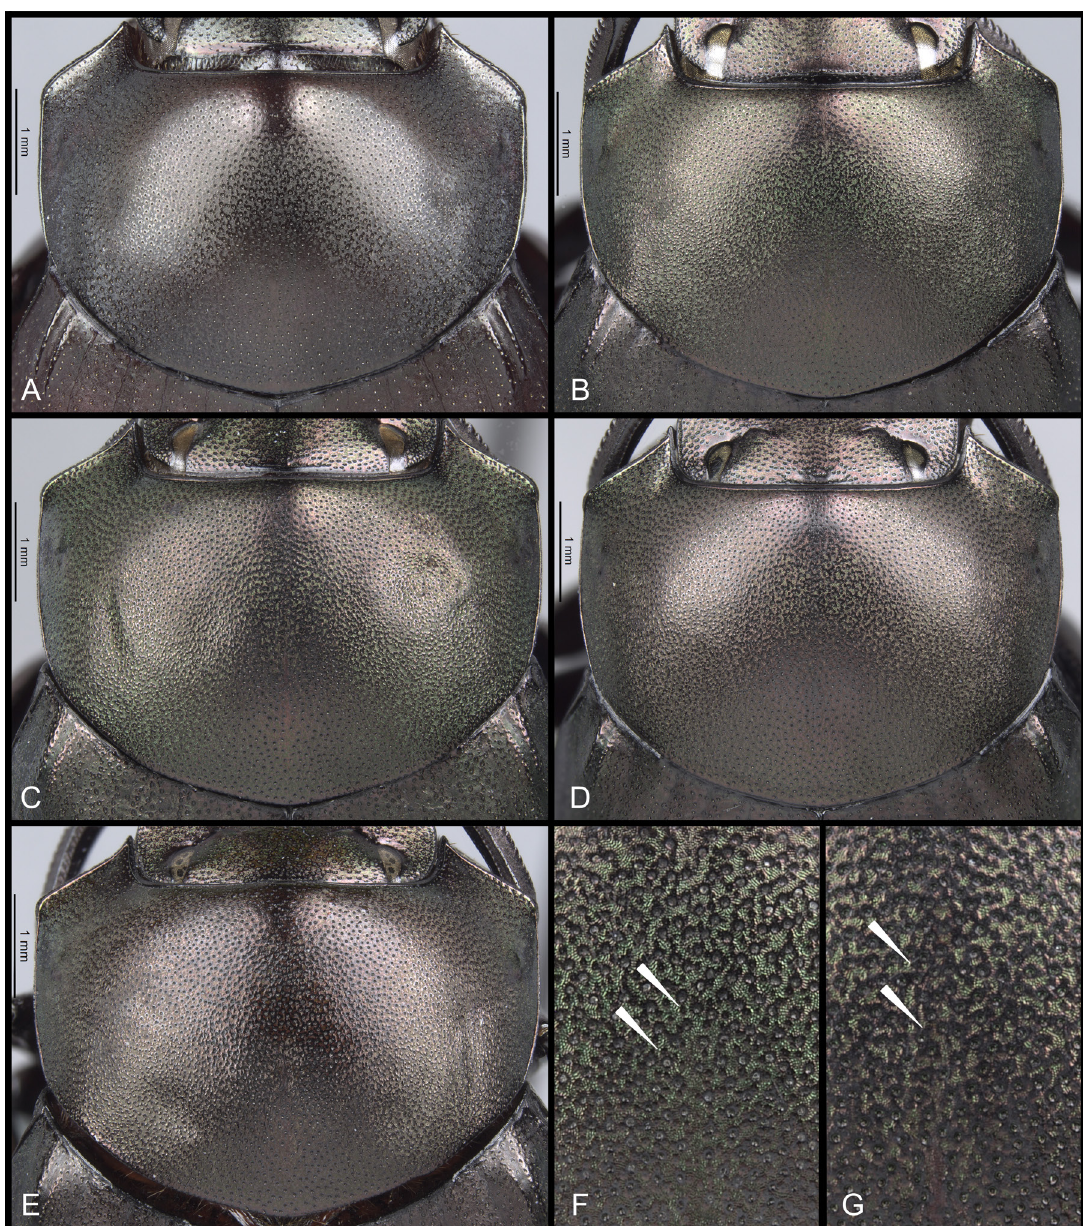
Fig. 3. Pronotum of members of the gilli species group. A . Holotype of Deltochilum gilli González- Alvarado & Vaz-de-Mello, 2021, CNCI 379888. B . Holotype of D. jocelynae sp. nov., CNCI 379889. C . Holotype of D . nonstriatum sp. nov., CMNEN WSD00041746. D . Holotype of D . quasistriatum sp. nov., CMNEN WSD00041744 E . Holotype of D . tenuistriatum sp. nov., CMNEN WSD00041745. F . Miscrosculpture of pronotal disc, Holotype of D. jocelynae sp. nov. G . Miscrosculpture pronotal disc, Holotype of D . nonstriatum sp. nov. White arrows show the shiny